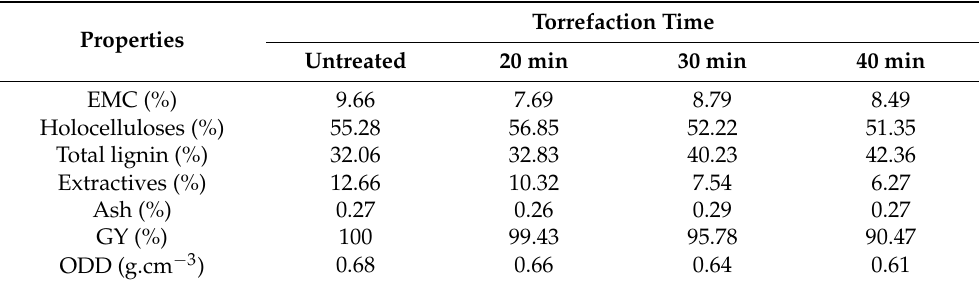
Table 1. Residue properties of untreated MDF and after torrefaction for 20, 30 and 40 min used in the test to evaluate damage by xylophage